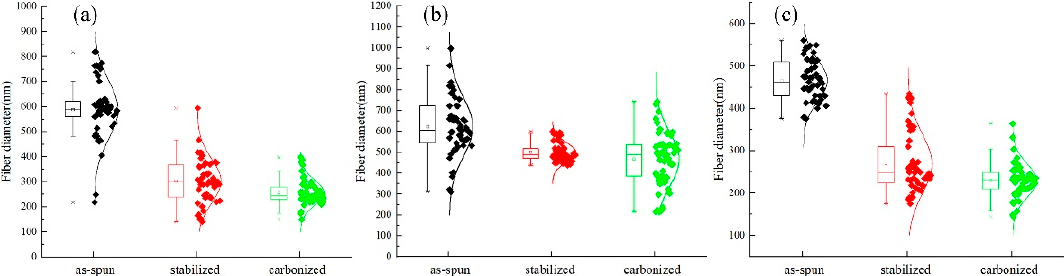
Figure 13. SEM image of membranes of different receiving distance at different processing stages.